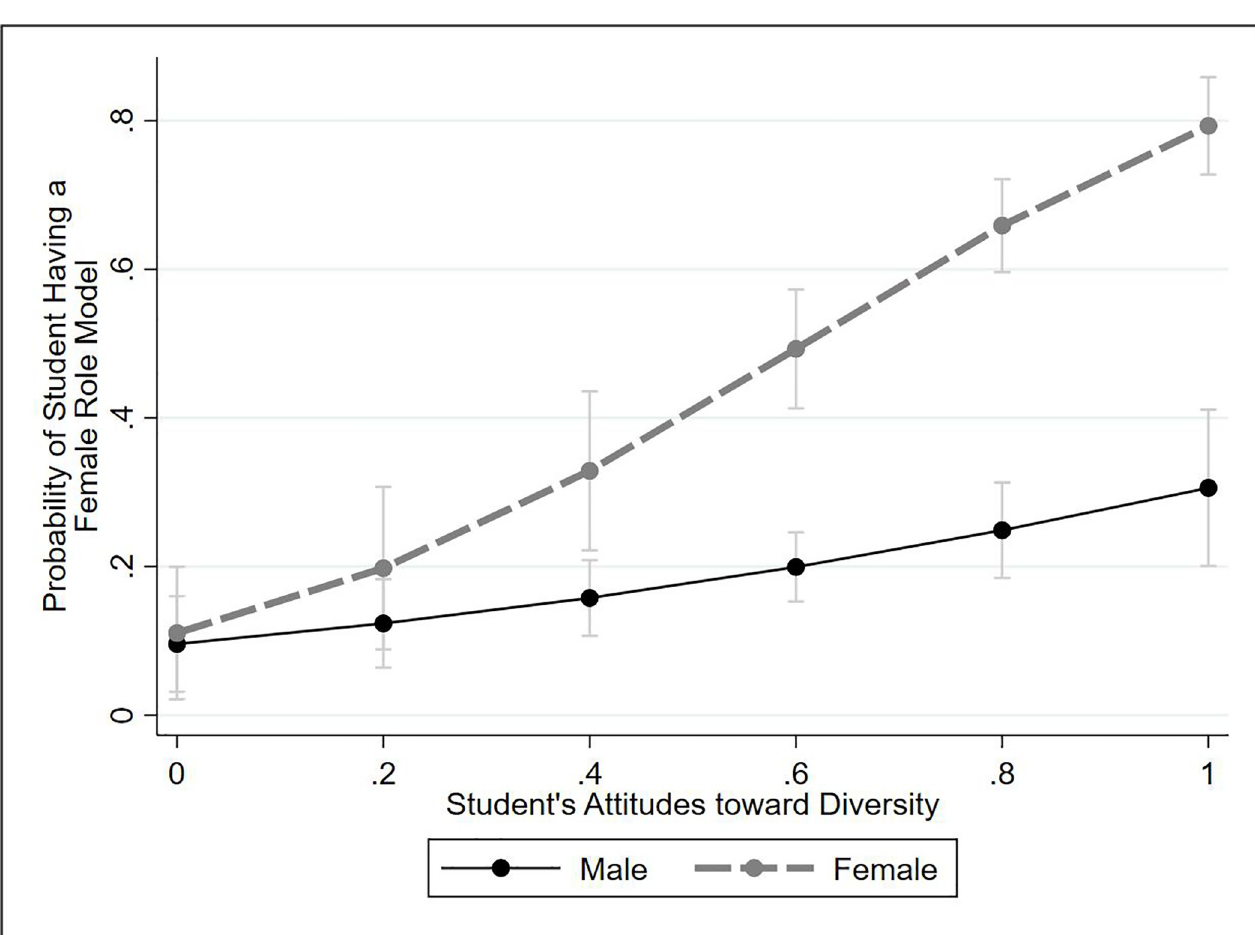
Fig 3. Impact of gender and attitudes toward diversity on having female role models. Results are predicted probabilities from a logistic regression model predicting likelihood of having a female role model (see S1 File for models). The figure shows 84% confidence intervals; visual comparison of two 84% CIs is equivalent to a single 95% test [64,